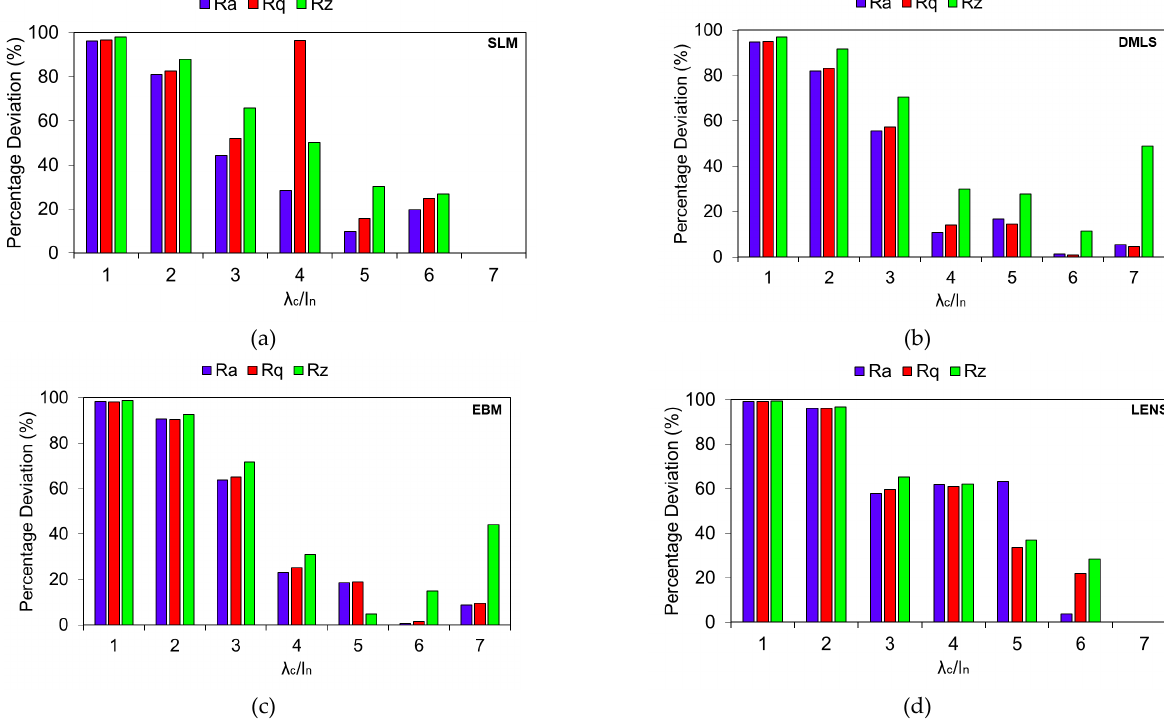
Figure 6. Percentage deviation in profile surface roughness results due to change in cut-off wavelength and evaluation length. ( a ) SLM; ( b ) DMLS; ( c ) EBM; ( d ) LENS.